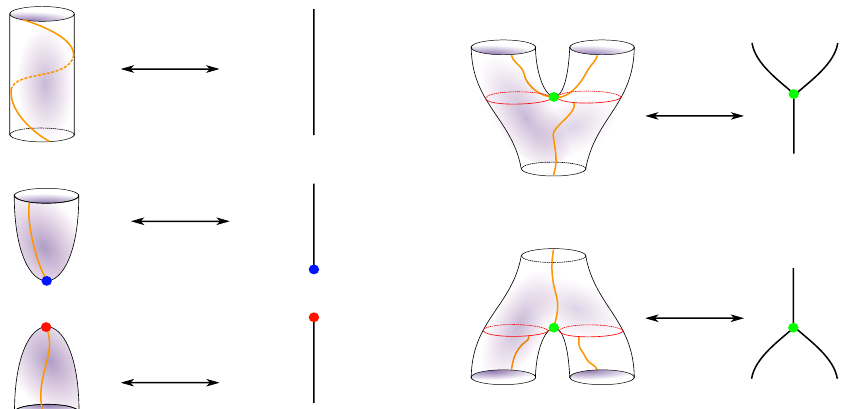
Figure 10. The restriction of the Reeb graph on the building blocks of a surface along with the part of the ascending paths in that part of the surface. Around each critical point, the structure of the ascending curves (orange) is identical to the structure of the Reeb graph. More precisely, the quotient space of the restriction of the function on the ascending curves the critical sets around a critical point (these are the curves highlighted by orange and red in the figure) is identical to the quotient space of the manifold